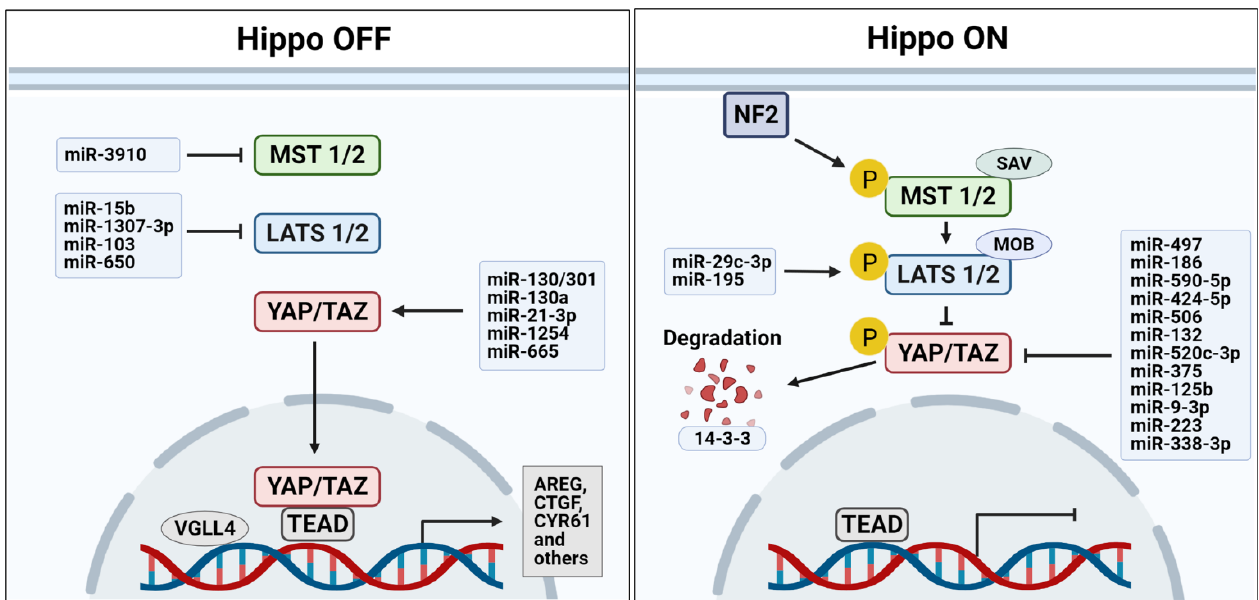
Figure 1. MicroRNAs that regulate the core components of Hippo signaling pathway . Several microRNAs are involved in kinase cascade (MST1/2 and LATS1/2) and downstream effectors (YAP/TAZ) of the Hippo signaling pathway in liver cancer as either oncogenes or tumor suppressors. Abbreviations: NF2, Neurofibromin 2; MST1/2, Mammalian STE20-like 1/2; SAV, Salvador; LATS1/2, Large Tumor Suppressor 1/2; MOB, Mps one binder kinase activator; YAP/TAZ, Yes-associated protein and transcriptional coactivator with PDZ-binding motif; TEAD, TEA domain family member; VGLL4, Vestigial like family member 4; AREG, amphiregulin; CTGF, connective tissue growth factor; CYR61, Cysteine-rich angiogenic inducer 61.